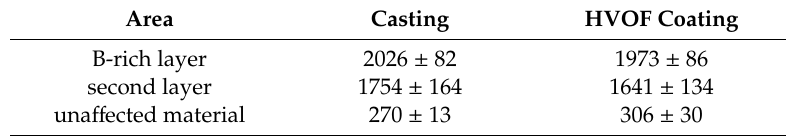
Table 5. Microhardness HV0.001 of CrFeCoNi casting and HVOF coatings in borided